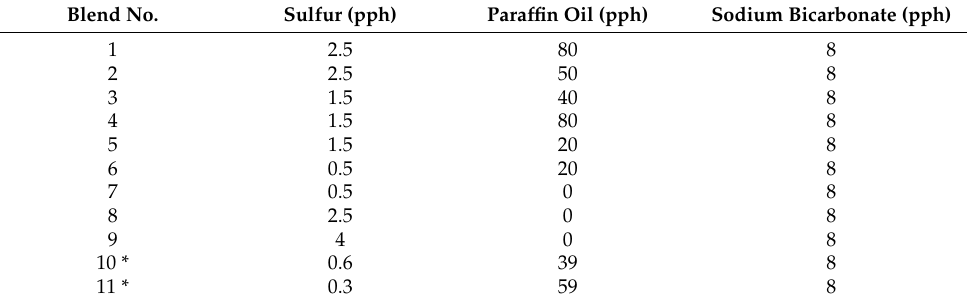
Table 2. Below depicts each blend formulation. Blend No. Sulfur (pph) Paraffin Oil